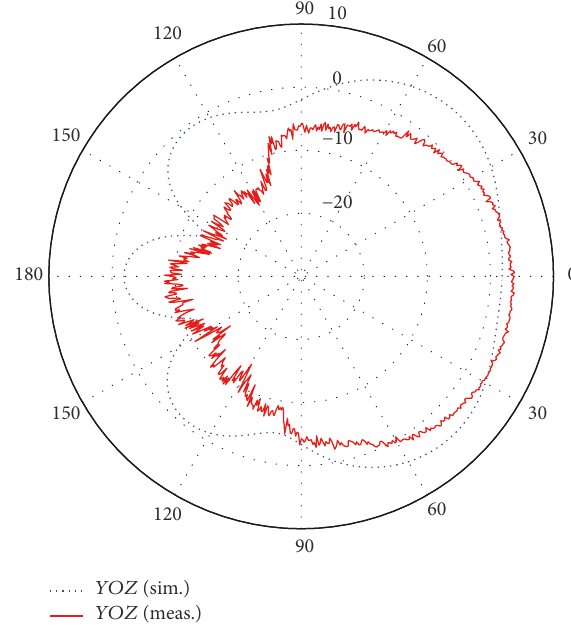
Figure 17: Radiation pattern of the antenna in YOZ plane at 5.8 GHz.